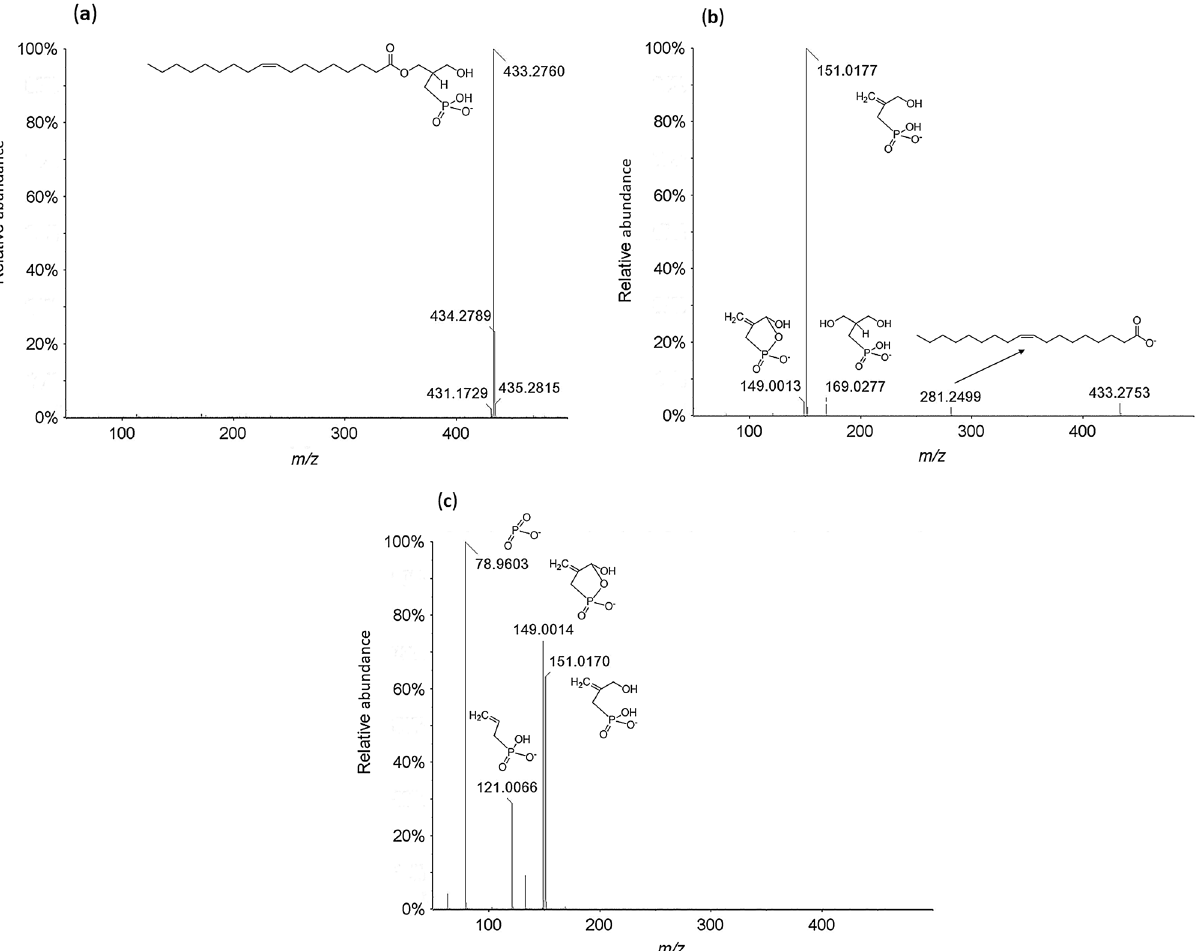
Figure 2. Full mass negative ion scan and proposed chemical structure of ( a ) 2-carba-cyclic phosphatidic acid (2ccPA) degradation compound determined by quadrupole time-of-flight mass spectrometry (QqTOF). ( b , c ) Product ion analysis of 2ccPA degradation compound at m / z 433.2760 performed by QqTOF using a peak width setting of 1.4 Th, by selection of the molecular ion in the first quadrupole and collision activation in the second quadrupole with a collision energy of ( b ) − 30 and ( c ) − 75 eV. Proposed structures of the product ions observed in the tandem mass spectrometry spectra are shown. Background subtraction was performed using the PeakView software version 1.2